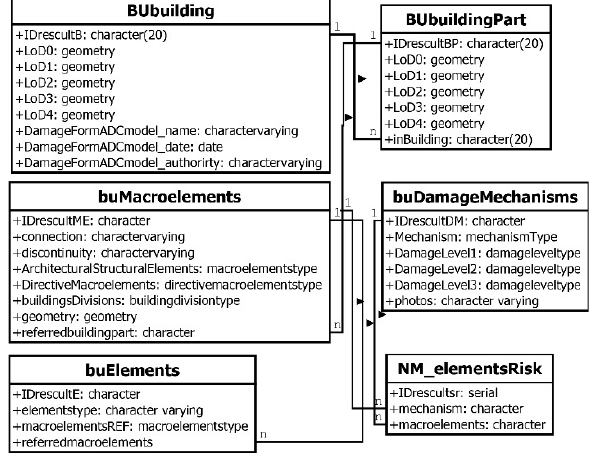
Figure 2. Proposed extension of the ResCult conceptual